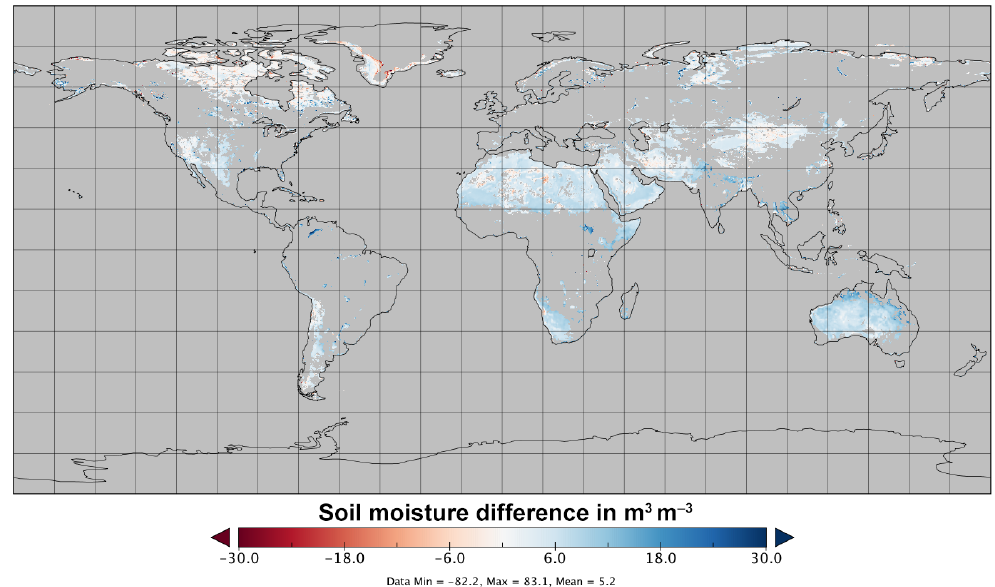
Figure C2. Absolute differences in soil moisture for AMSR2 (AMSR2 NRT minus AMSR2 offline) for the entire year 2013 (masked according to the blending map in Fig.